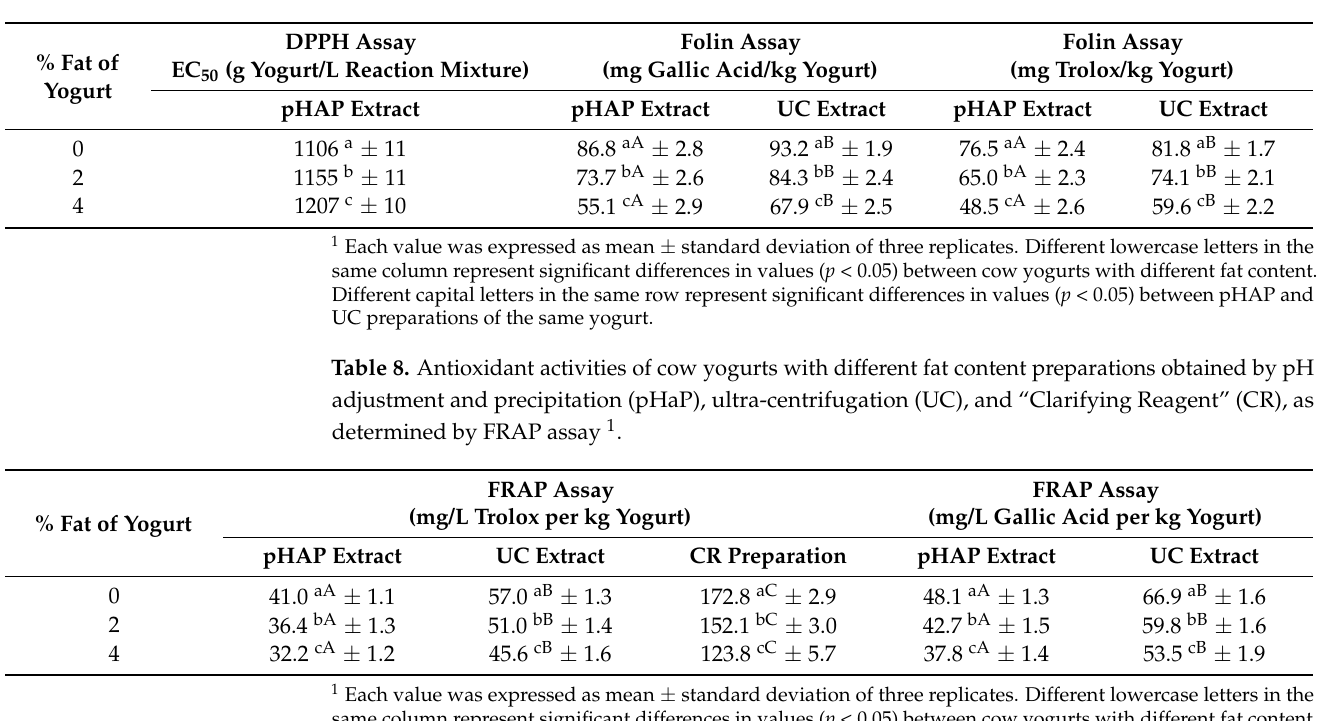
Table 7. Antioxidant activities of cow yogurts with different fat content preparation obtained by pH adjustment and precipitation (pHAP) or ultra-centrifugation procedure, as determined by DPPH and Folin assays 1 .